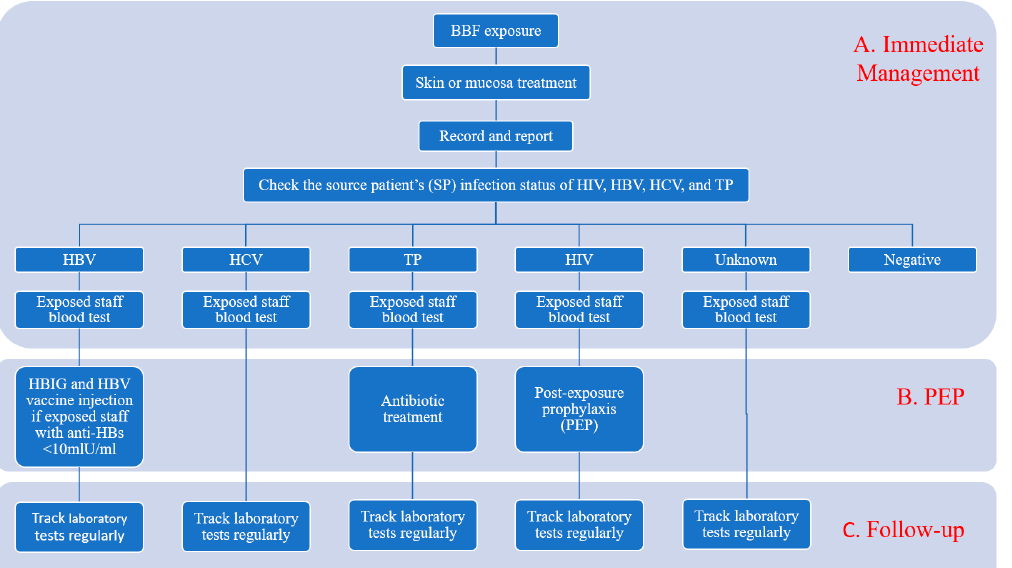
Figure 1. Process of management of occupational exposure to BBF in the healthcare facilities of Beijing, China. BBF: blood and body fluid; HIV: human immunodeficiency virus; HBV: hepatitis B virus; HCV: hepatitis C virus; TP: Treponema pallidum ; PEP: post-exposure prophylaxis; HBIG: human hepatitis B immunoglobulin.